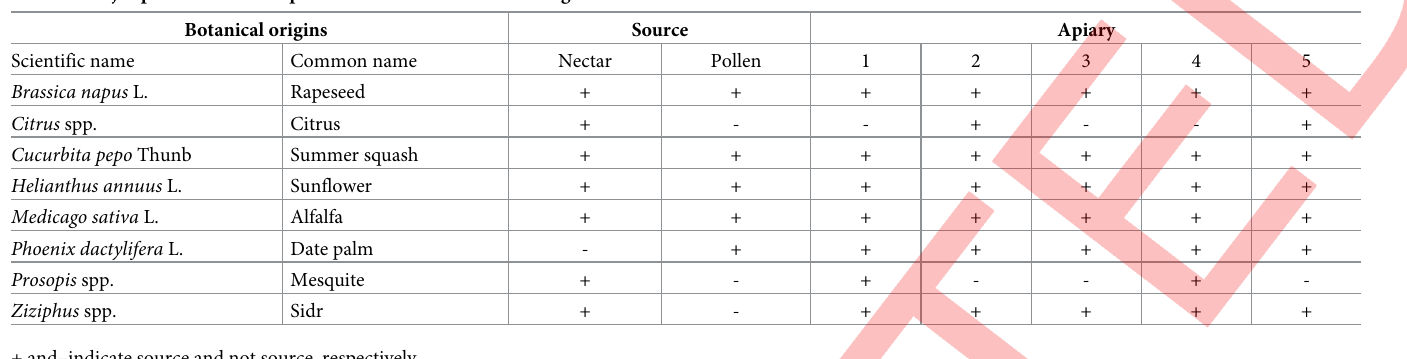
Table 1. Major pollen and nectar plants in the Al-Ahsa oasis during